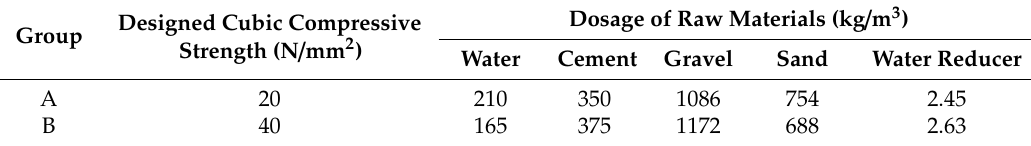
Table 2. Mixture proportion of concrete.